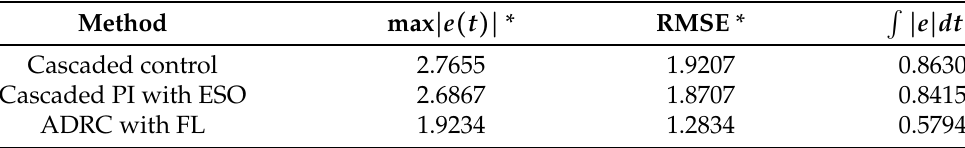
Table 3. Trajectory tracking performance of different control